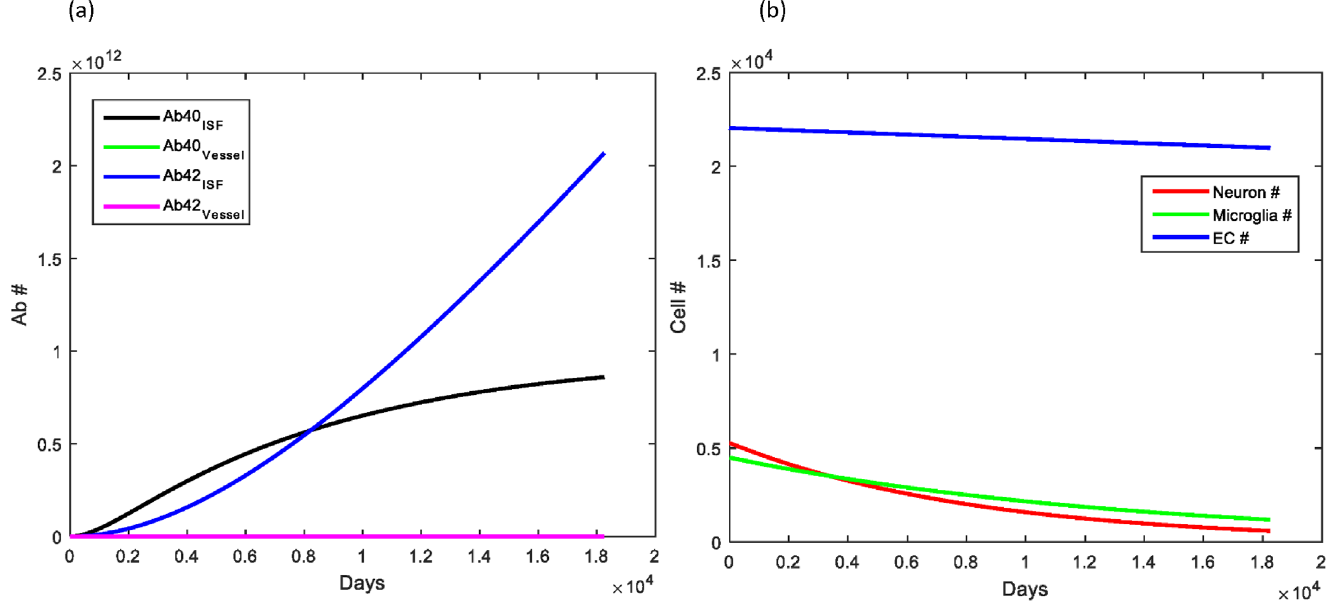
Fig 5. Effect of vessel stiffness on A β clearance and deposition. (A) Increasing the stiffness slowly by a factor of 2 during aging led to a significant increase in the amount of A β deposited within the brain parenchyma, with a decrease in the amount reaching and thus depositing in cerebral vessels. (B) The high A β levels in the brain parenchyma led to accelerated neuronal loss with no change observed in microglia or brain endothelial cell number.